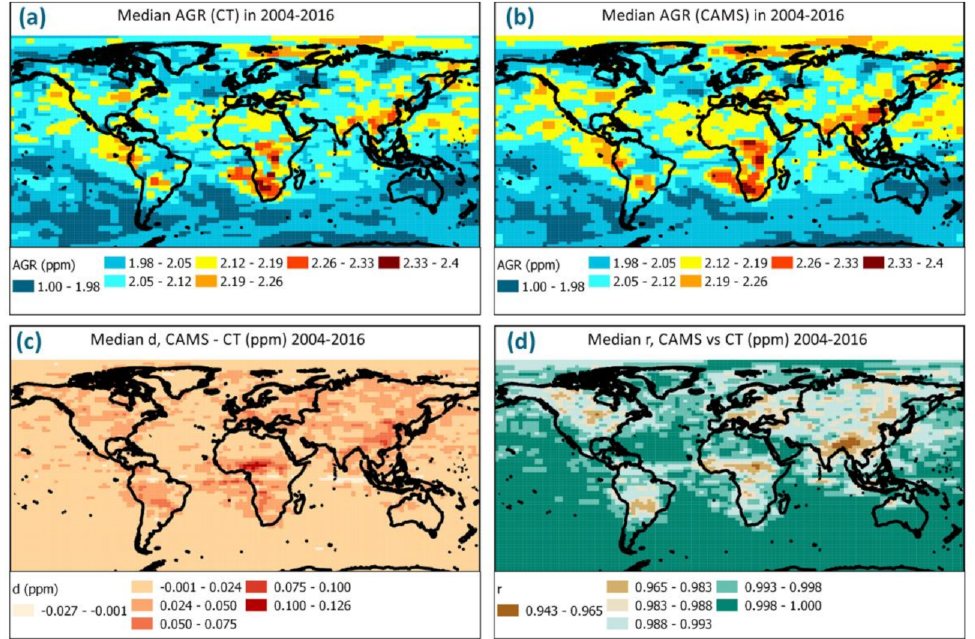
Figure 10. Median estimates of AGR from the models for CT (panel ‘ a ’) and for CAMS (panel ‘ b ’) in 2004–2016 period. Panel ‘ c ’ shows the difference between AGR estimates (CT and CAMS) in 2004–2016 period (median for the entire period is shown). Panel ‘ d ’ shows grid cell correlation (r) between two modeled AGRs (CT and CAMS). All estimates are provided with 3 ◦ × 2 ◦